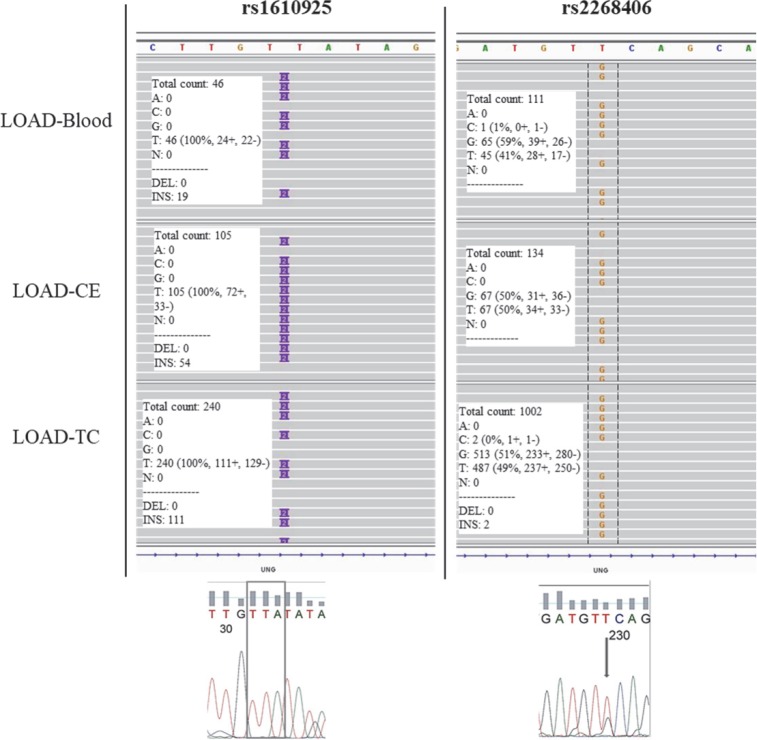
Identification and validation of genetic variants in UNG gene in LOAD patient’s blood, CE and TC samples.Targeted NGS results with corresponding Sanger sequencing validation of heterozygous variants UNG rs1610925 and rs2268406 in the blood of LOAD patients. NGS data are presented using the Integrative Genomics Viewer (IGV) software. Arrows and boxes indicate the position of the variant in the Sanger sequencing chromatograms. CE, cerebellum; TC, temporal cortex.